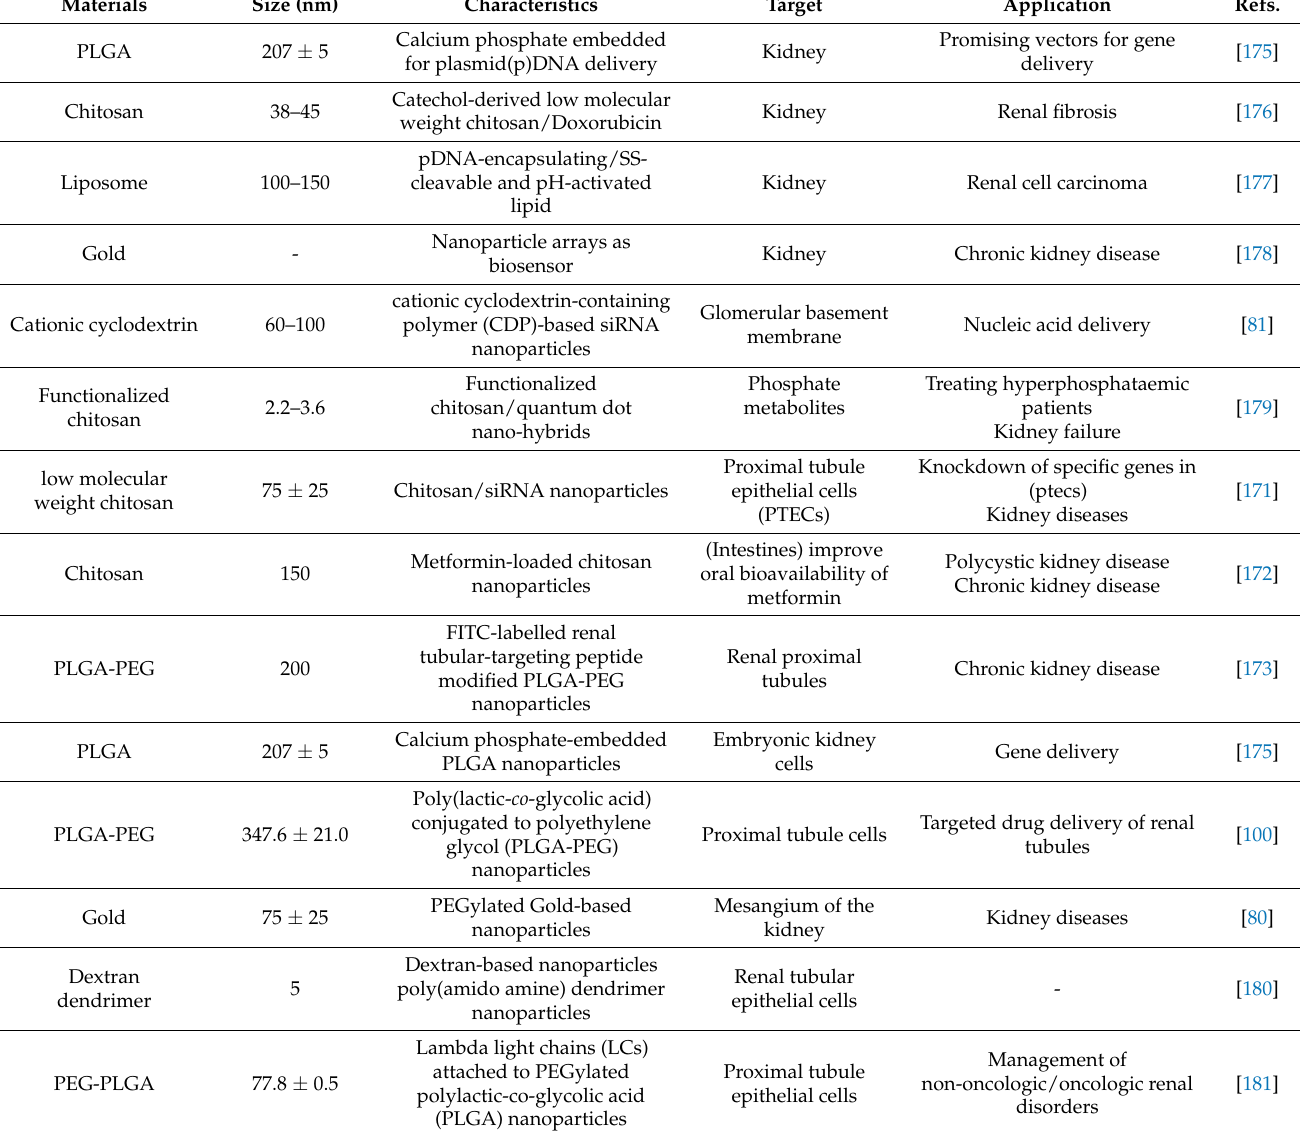
Table 4. Nanotechnology applications in the development of kidney-targeted drug delivery